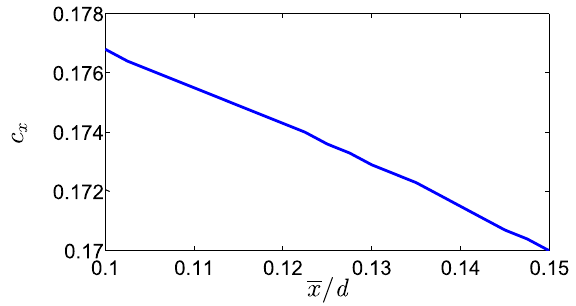
FIG. 5. Weighting factor c x as a function of ¯ x=d ; c y ¼ 0 . 1885 , σ =d ¼ 0 . 15 , σ =d ¼ 0 . 075 , ¯ y ¼ 0 . x y